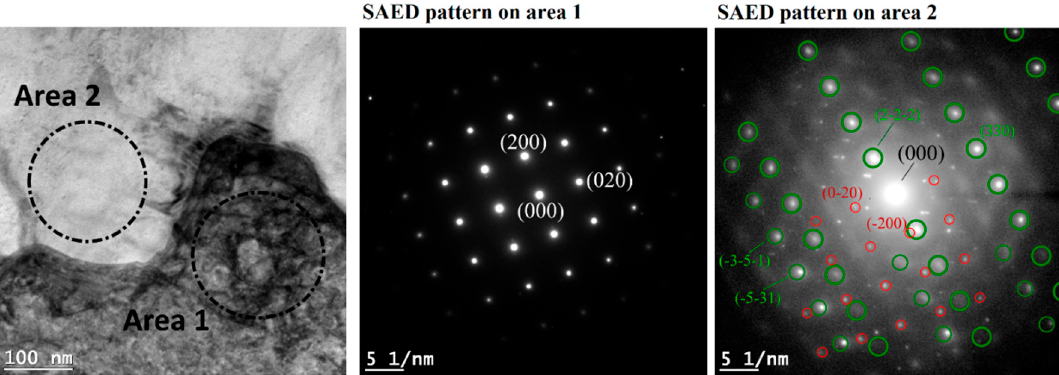
Figure 17. Transmission electron microscope (TEM) image showing the interface between γ phase (dark contrast) and an interdendritic precipitate (bright contrast) with respective selected area electron diffraction (SAED) patterns, both taken along the [001] zone axis of the γ phase. On the SAED pattern on area 2, the green circles underline diffraction points of Laves phase along its (cid:4670)11(cid:3364)2(cid:4671) zone axis, instead red circles underline diffraction points of the γ phase.